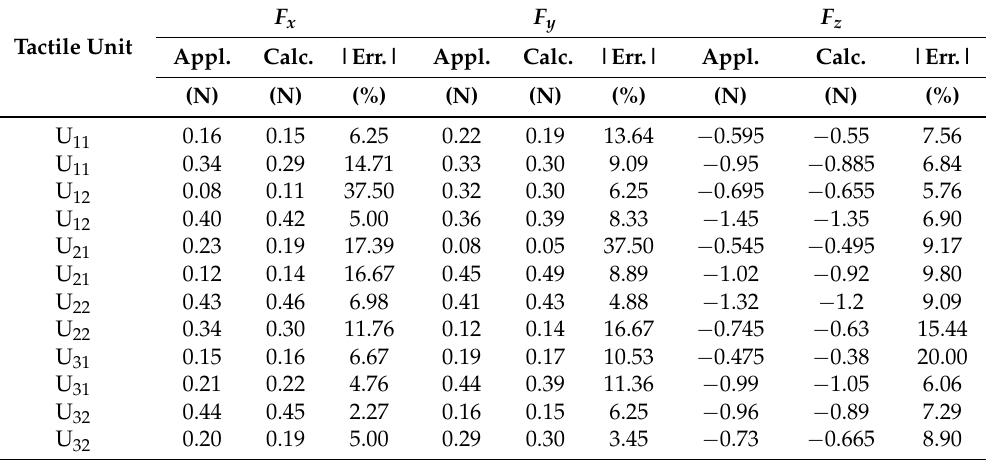
Table 1. Applied and calculated force components on the sensor array.